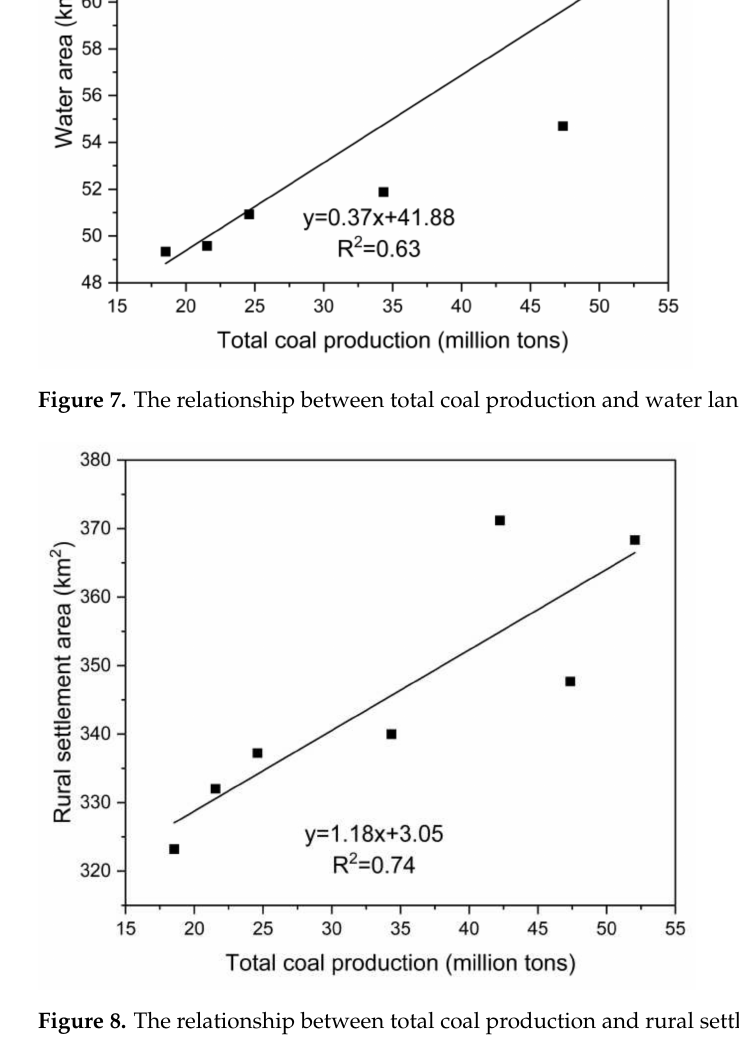
Figure 8. The relationship between total coal production and rural settlement